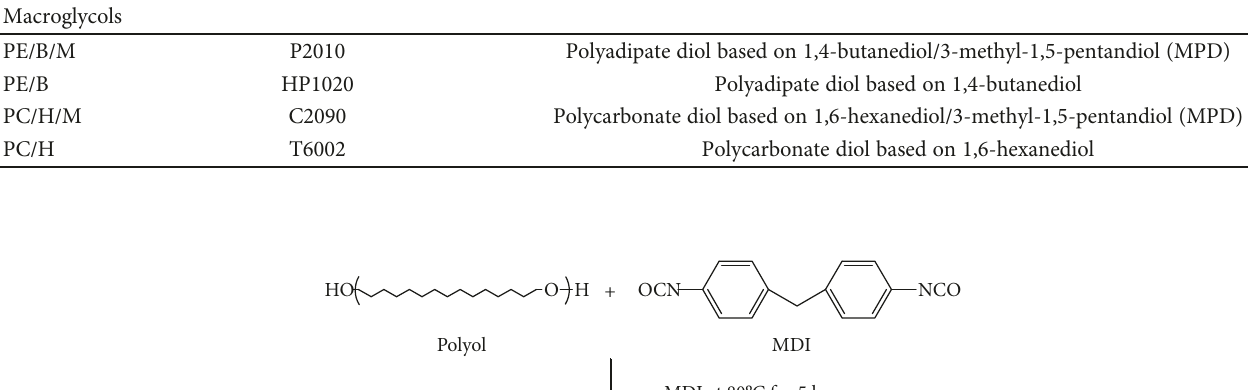
Table 1: Four di ff erent macroglycols used in this study.